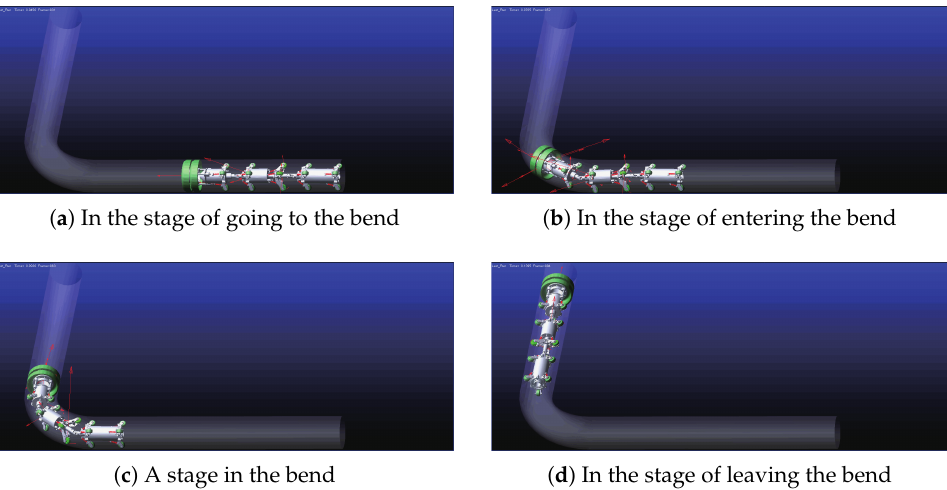
Figure 11. Simulation schematic of the virtual prototype robot bending.